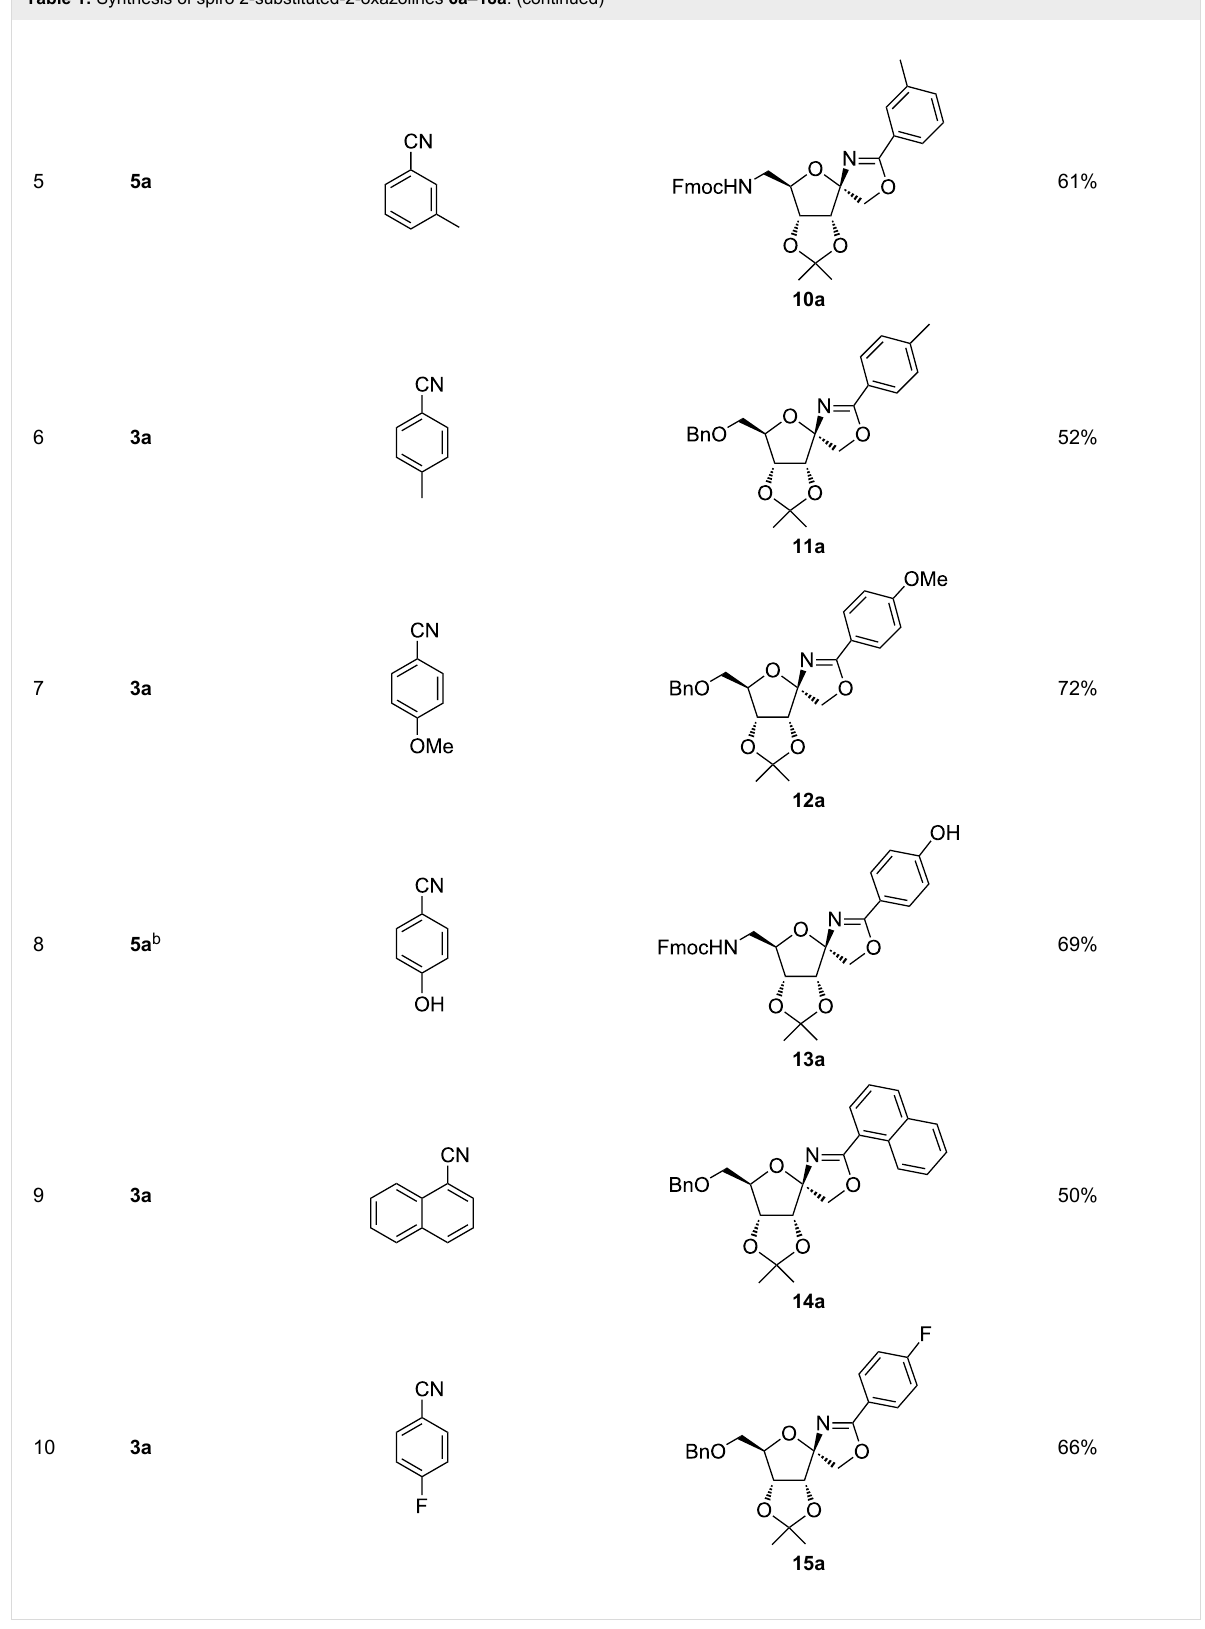
Table 1: Synthesis of spiro 2-substituted-2-oxazolines 6a–18a .